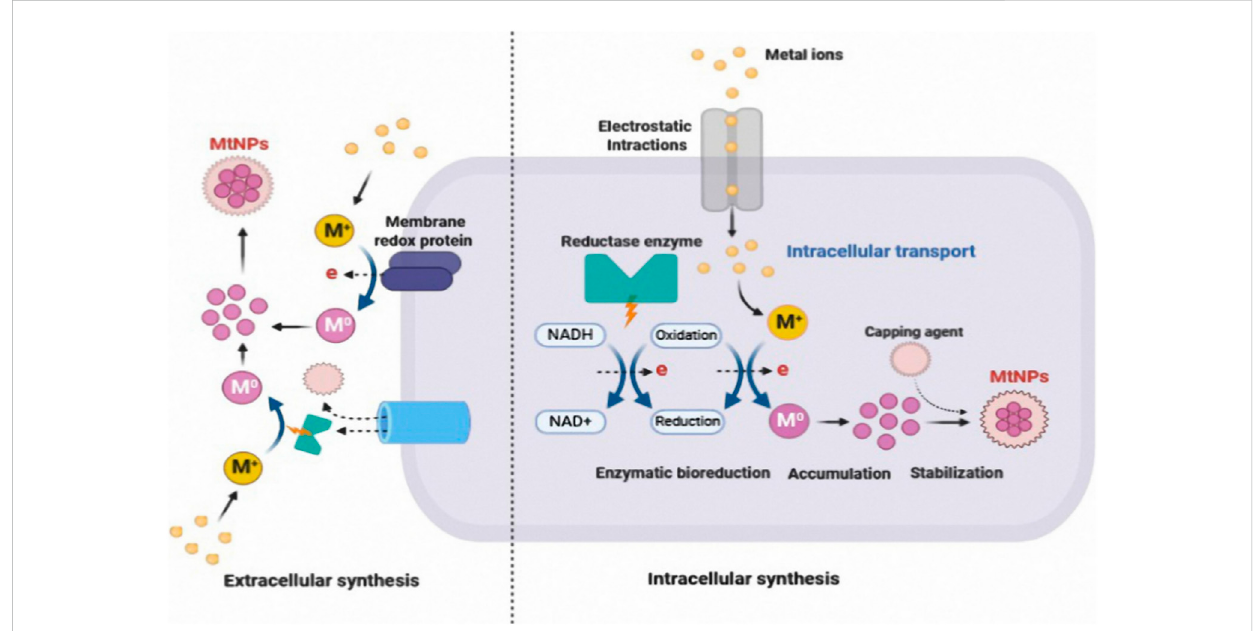
FIGURE 4 Mechanism of extracellular and intracellular biogenic synthesis of metal nanoparticles Adapted from Ref (Bahrulolum et al., 2021). CC BY